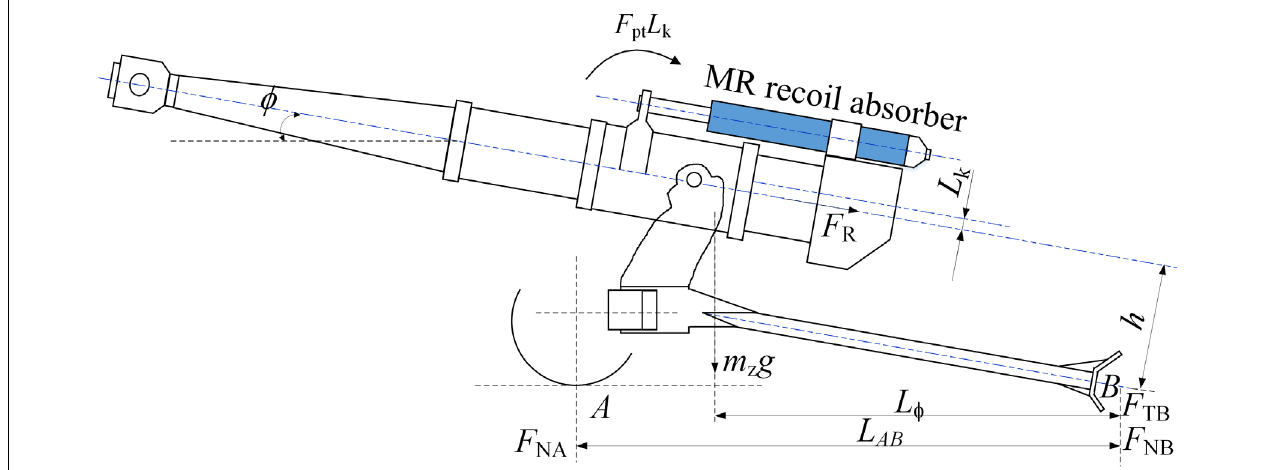
FIGURE 1 | Structural diagram of recoil